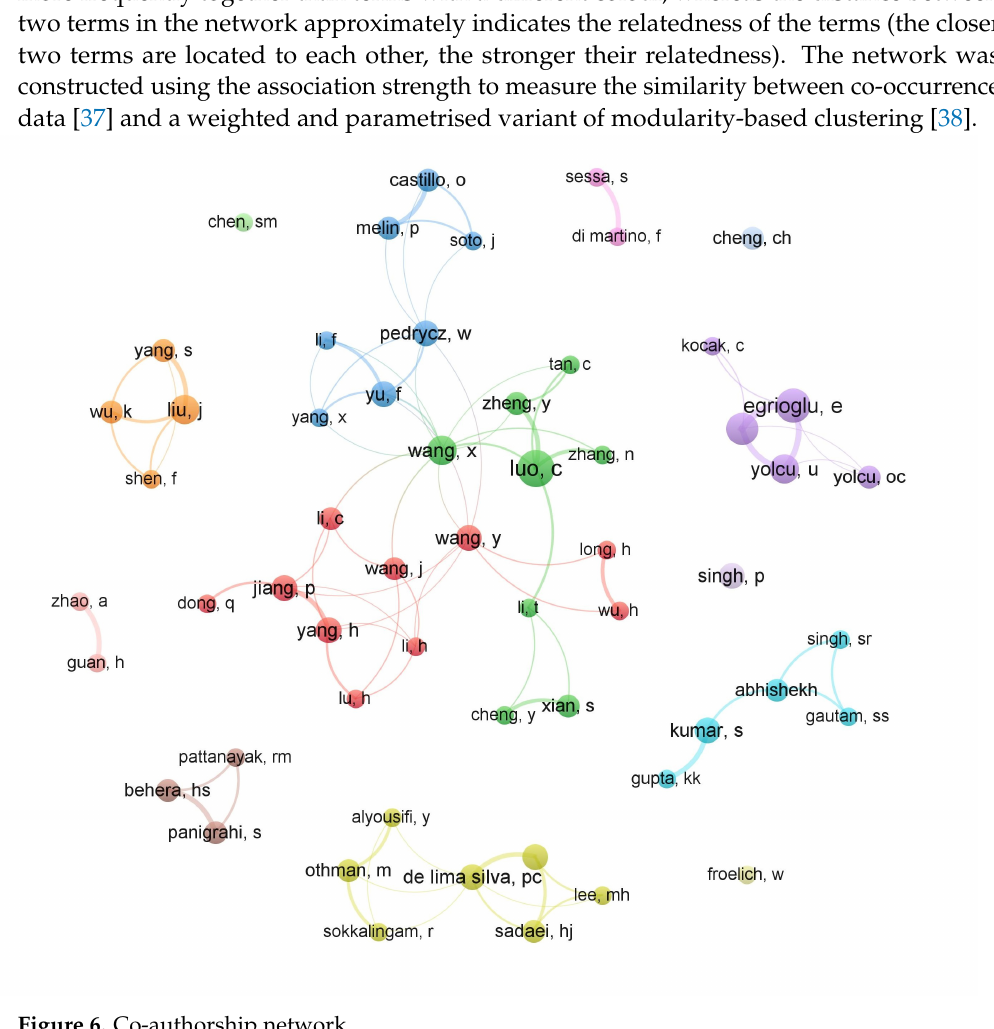
Figure 6. Co-authorship